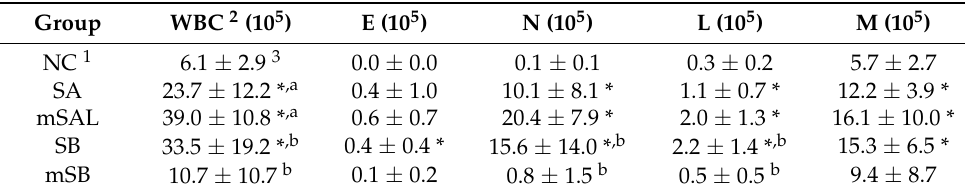
Table 11. Changes of bronchoalveolar lavage fluid, WBC total count, and WBC differential count